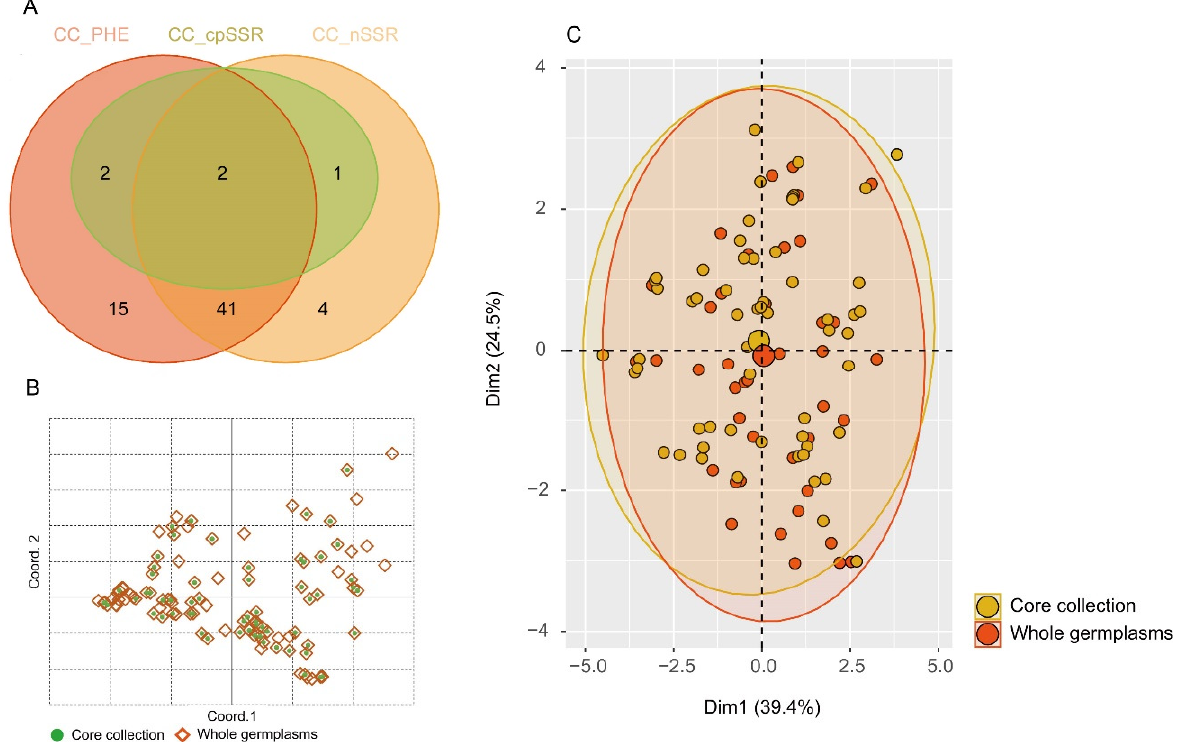
Figure 4. The extraction and representative verification of core collection with the whole germplasms. ( A ) Venn diagrams of phenotypic and SSR data building the core collection, CC_cpSSR, core collection extracted through cpSSR marker data, CC_nSSR, core collection extracted through nSSR marker data, CC_PHE, core collection extracted through phenotypic traits data. ( B ) Principal coordinates analysis (PCoA) plot of the core collection and whole collection. ( C ) Principal component analysis (PCA) plot of the core collection and whole collection.